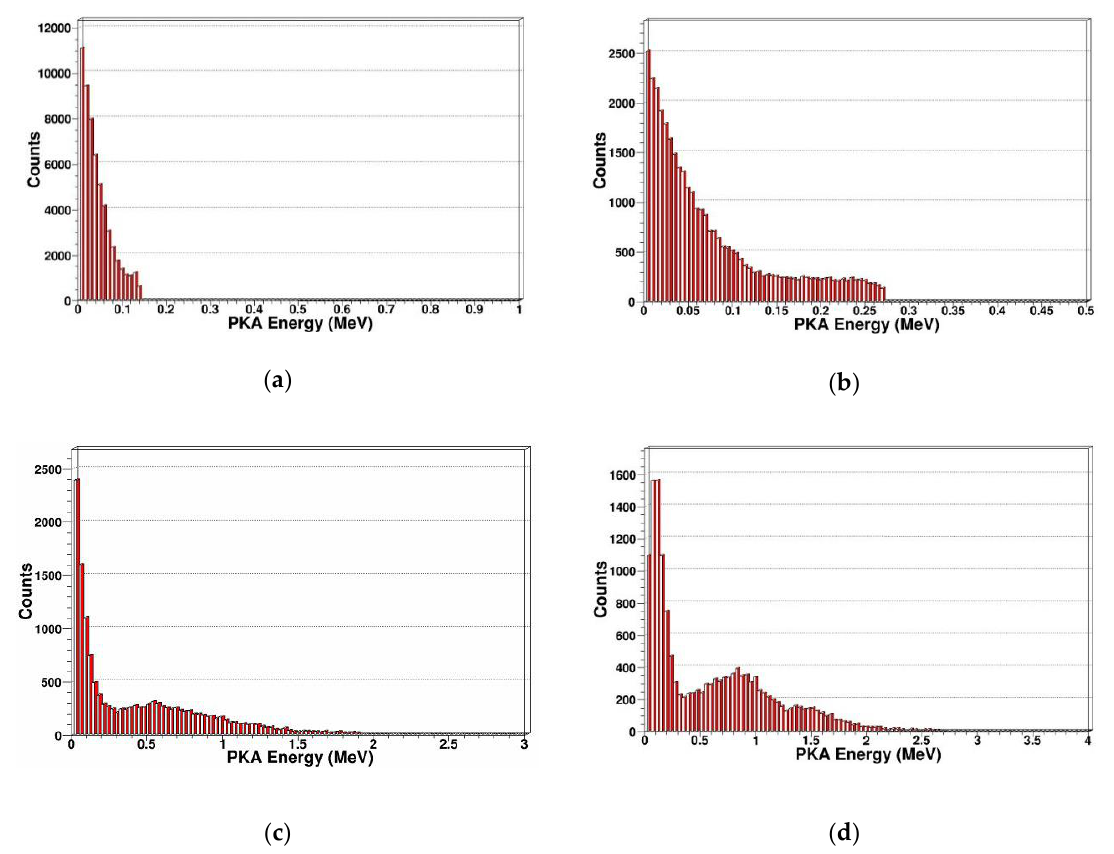
Figure 5. PKA energy spectrum in SDD generated by neutrons: ( a ) PKA energy spectrum for 1 MeV neutrons; ( b ) PKA energy spectrum for 2 MeV neutrons; ( c ) PKA energy spectrum for 14 MeV neutrons; ( d ) PKA energy spectrum for 20 MeV neutrons.